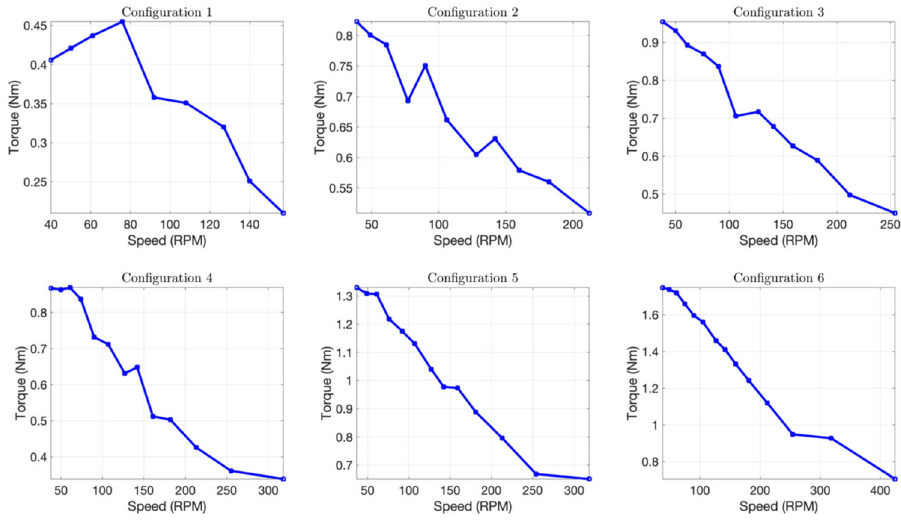
Figure 13. Speed–torque performance for all six configurations in AFM.